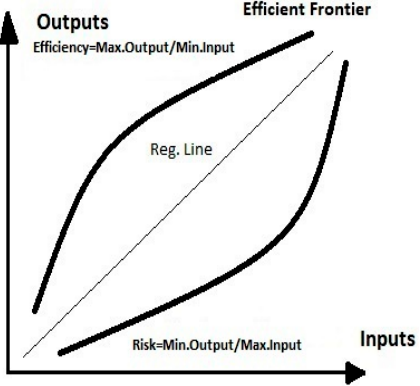
Figure 3. Basic data envelopment analysis (DEA) model conceptual diagram .